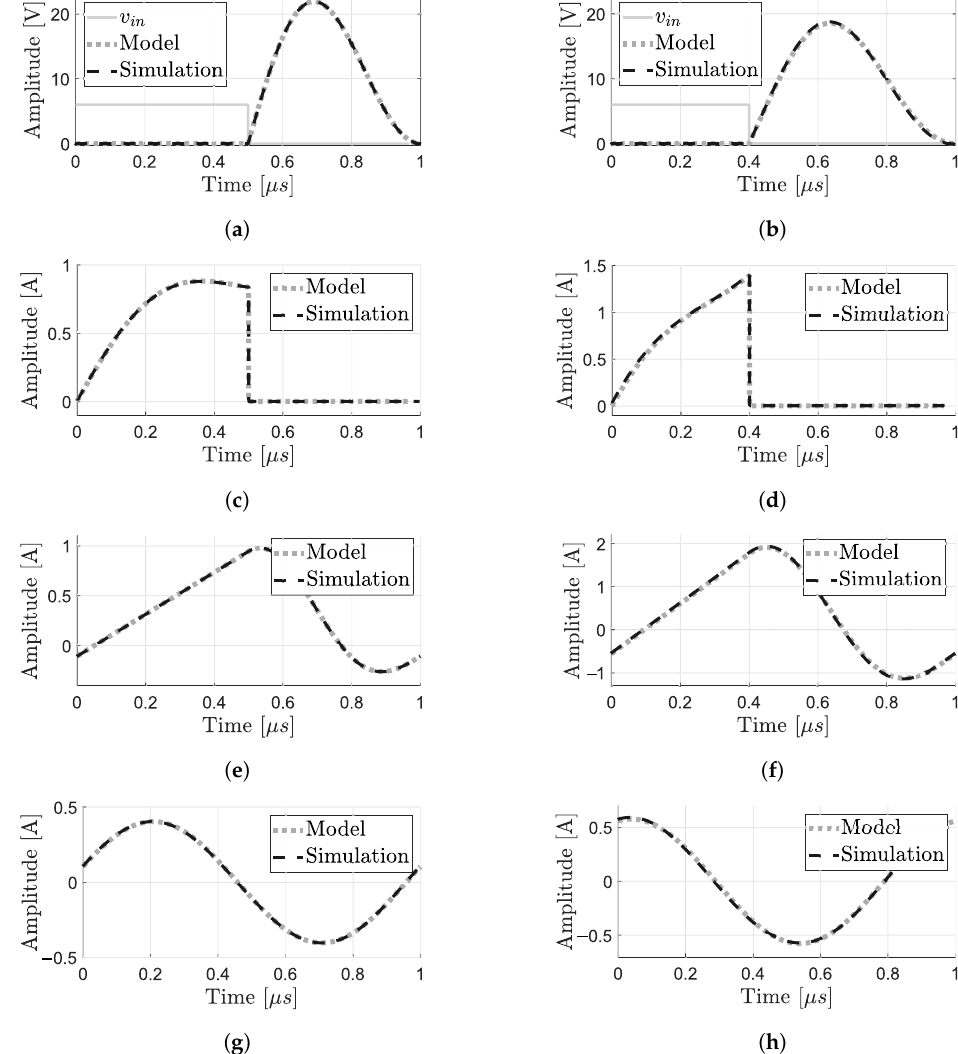
Figure 9. Class-E PA waveforms. ( a ) v S ( d ) i S of ID 6. ( e ) i L W